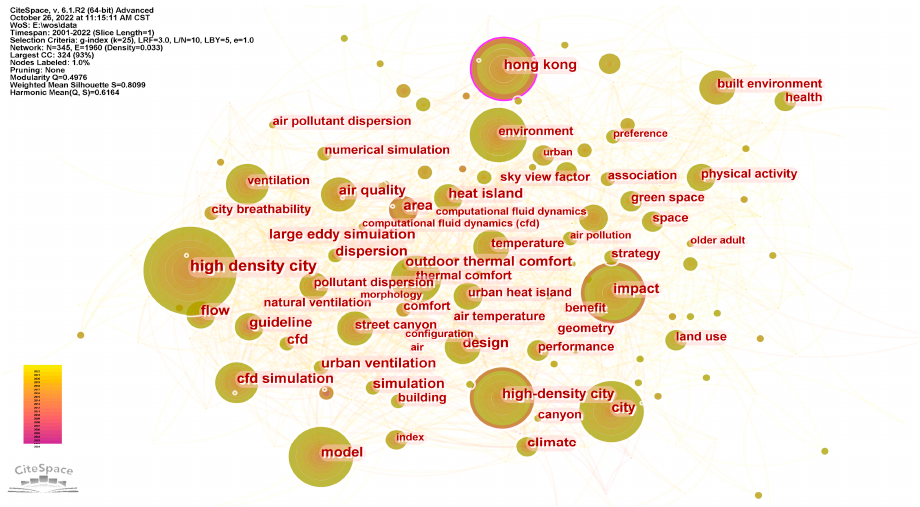
Figure 9. Knowledge map of major keywords in high-density city research from 2001 to 2022. Table 8. Major keywords in high-density city research from 2001 to 2022. No. Freq. Centrality Year